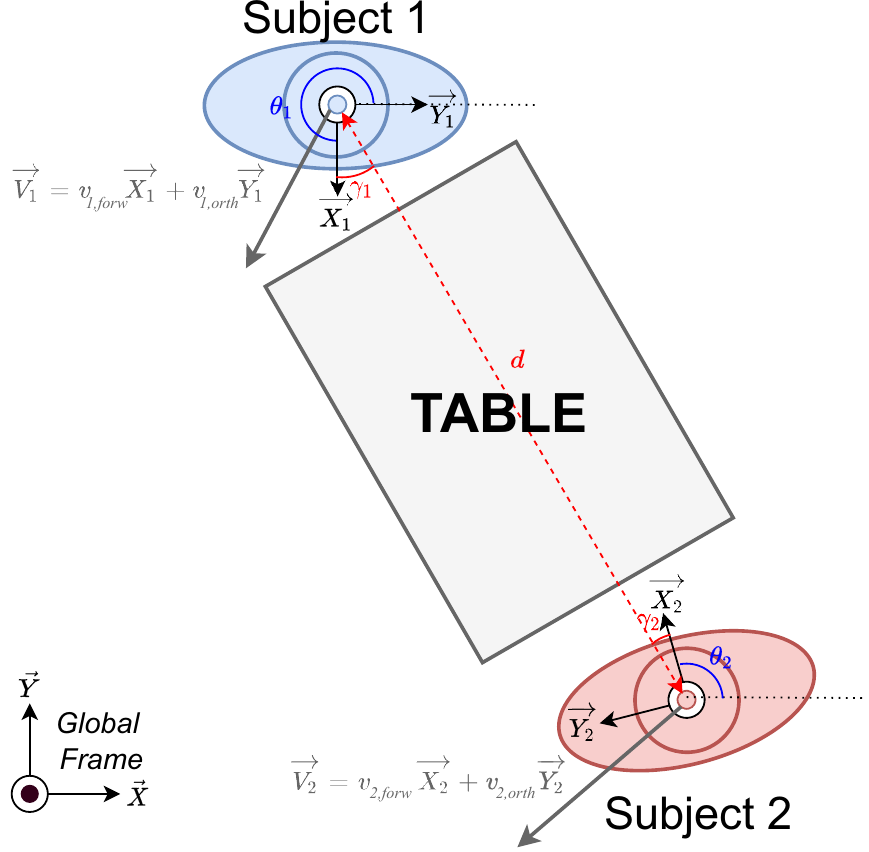
Figure 2. Coordinate systems and orientations in the trajectory problem to